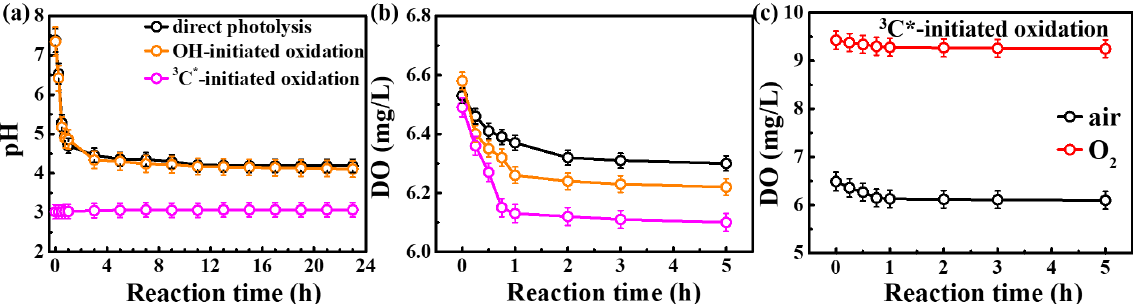
Figure 4. (a) pH values and (b) dissolved oxygen (DO) contents against reaction time under direct photolysis, OH-initiated oxidation, 3 C ∗ -initiated oxidation, and (c) DO contents during 3 C ∗ -initiated oxidation under air or O